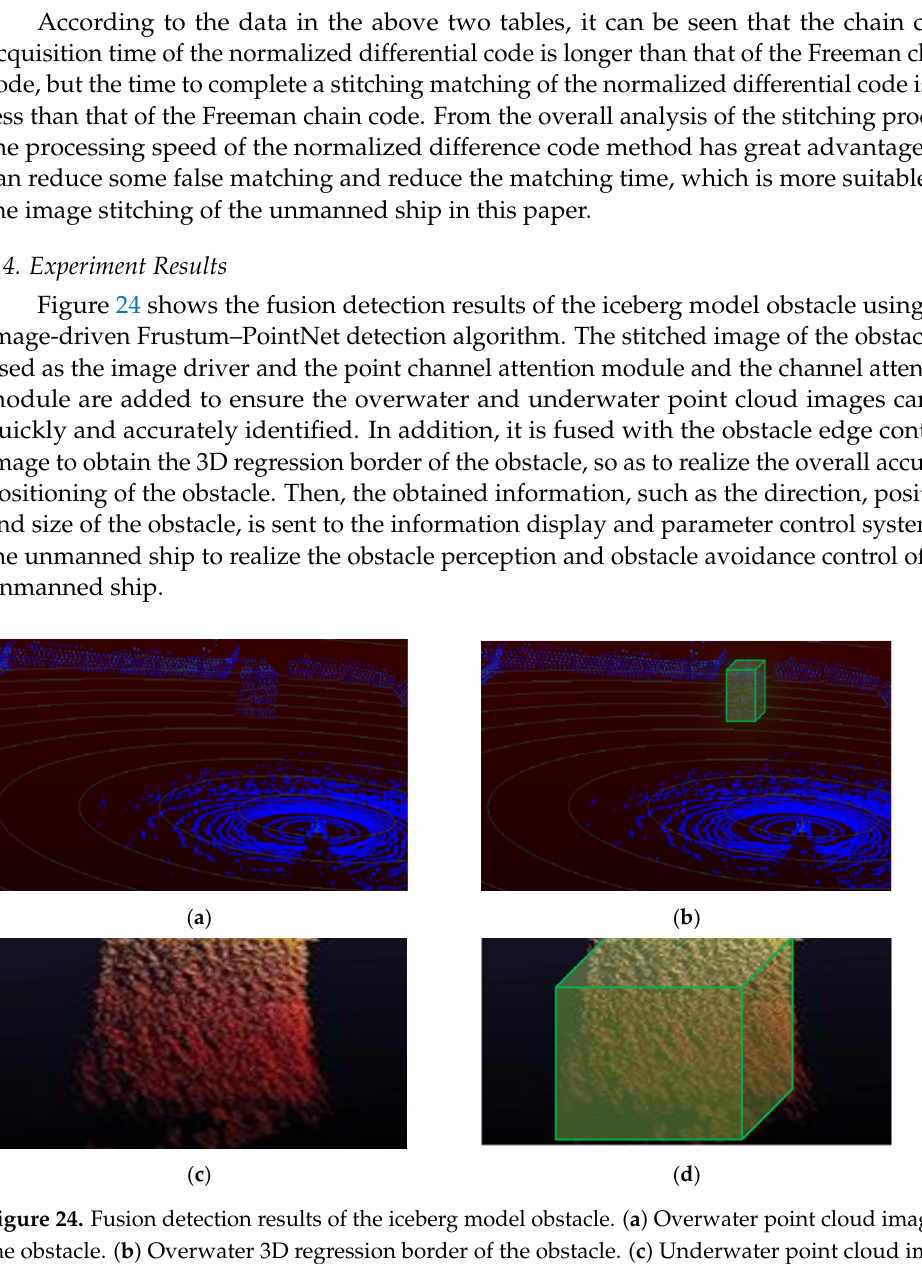
Table 7. Comparison of 3D detection accuracy of different fusion algorithms.